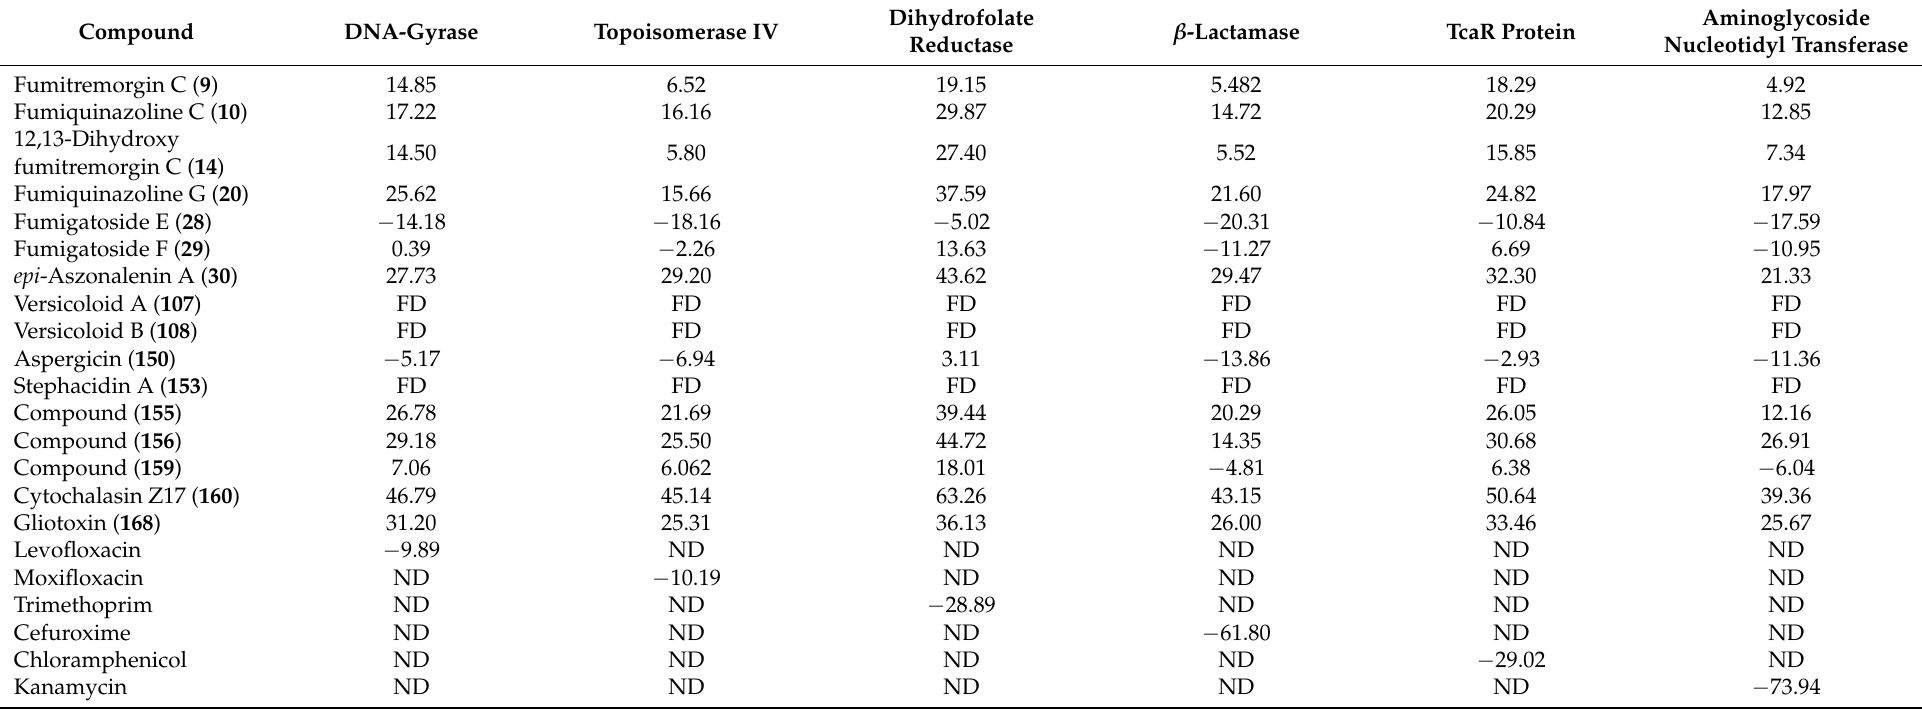
Table 2. Free binding energies ( ∆ G) in Kcal/mol of alkaloids isolated from Aspergillus and showed anti-infective potential using in silico studies on different microbial proteins.